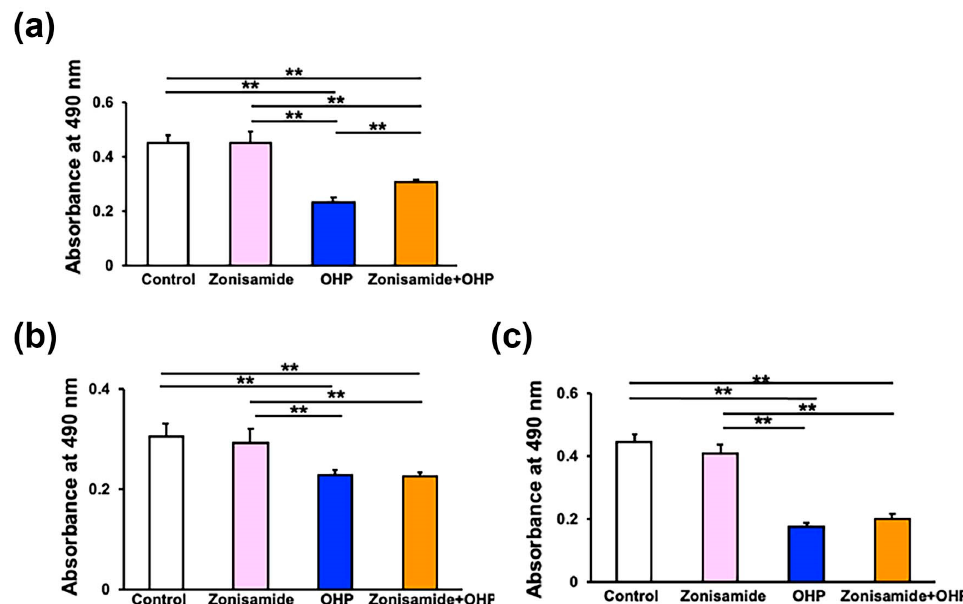
Figure 2. Pretreatment with zonisamide alleviates the OHP-induced toxicity against ND7/23 cells, but not against IFRS1 cells; results refer to an MTS assay: ( a ) Preincubation of zonisamide (100 µ M) for 6 h mitigates the ND7/23 cell death due to exposure to OHP (75 µ M) for 24 h. ( b , c ) Preincubation of zonisamide (100 µ M) for 6 h fails to mitigate the cell death caused as a result of exposure to OHP (75 µ M) for ( b ) 24 h or ( c ) 48 h. Data are presented as the mean ± SD of ( a ) 16, ( b ) 12, and ( c ) 30 experiments, respectively; **: p < 0.01 (as defined by